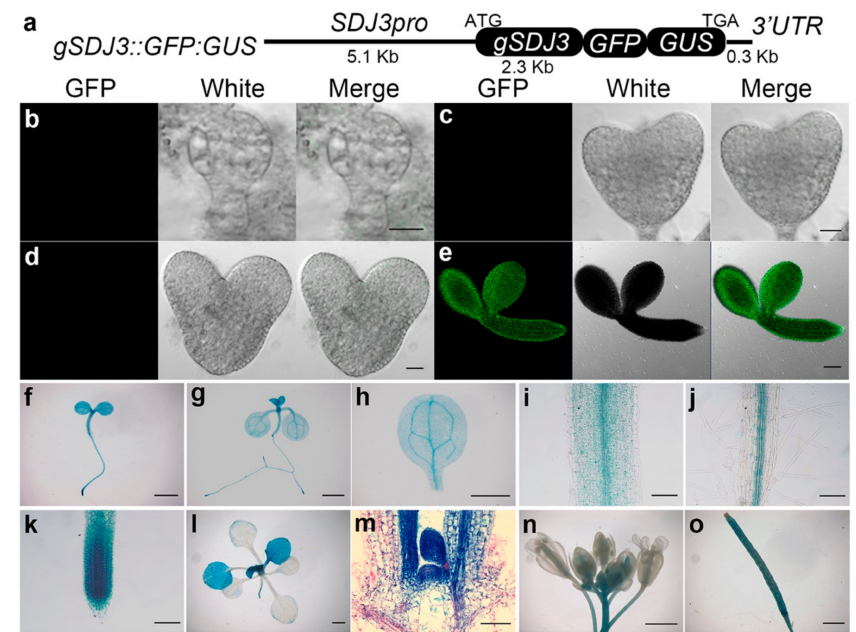
Figure 4. Expression of SDJ3 gene in different organs at different developmental stages. ( a ) Diagram of gSDJ3::GFP:GUS construct. ( b – e ) SDJ3:GFP:GUS fusion protein is expressed at mature stage ( e ), but not global stage ( b ), heart stage ( c ), and torpedo stage ( d ) during the embryogenesis of gSDJ3::GFP:GUS plant by GFP fluorescence scanning. ( f – o ) Expression of SDJ3:GF:GUS fusion protein in 3-day-old seedling ( f ), 7-day-old seedling ( g ), cotyledon ( h ), hypocotyl ( i ), root ( j ), and RAM ( k ) of 7-day-old seedling, 14-day-old seedling ( l ), SAM of 14-day-old seedling ( m ), Flower ( n ), and Silique ( o ) examined by GUS staining. Scale bar= 10 µ m in ( b – d ); 50 µ m in ( e , m ); 1000 µ m in ( f – l , n ) and o; 100 µ m in ( i – k ).